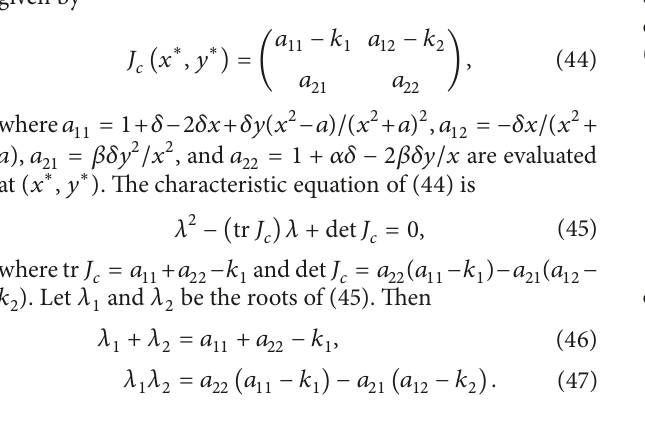
The Jacobian matrix 𝐽 𝑐 of the controlled system (43) is given